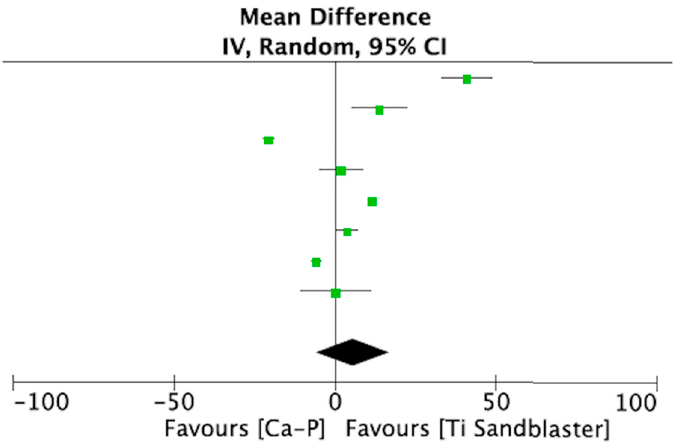
Figure 3. Forest plot for meta-analysis of studies evaluating BIC at 4 weeks after placement, assuming a random-effects model.